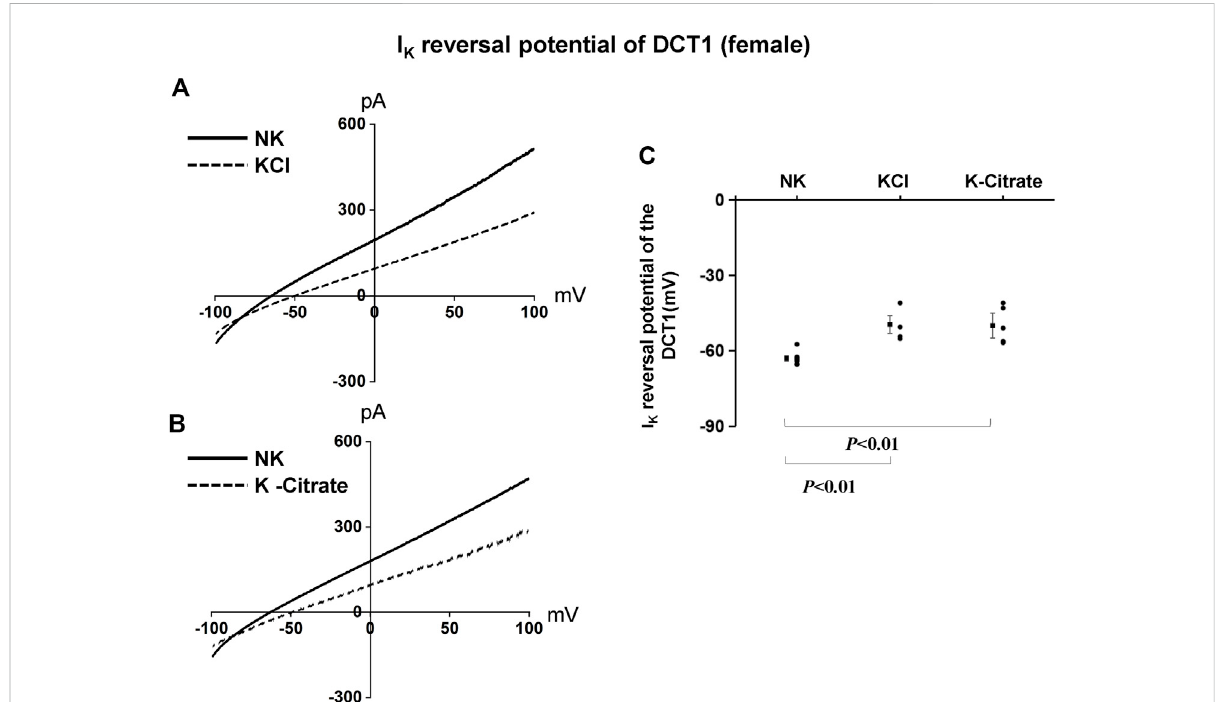
FIGURE 7 HK similarly depolarizes the basolateral membrane of the DCT in female mice regardless Cl − content. A set of whole-cell recordings shows I K reversalpotentialintheDCToffemalemiceonNKor5%K-Cldietfor7 days (A) andonNKor5%K-citratedietfor7 days (B) .Forthemeasurementof I K reversal potential, the bath solution contained 140 mM NaCl and 5 mM KCl, and the pipette solution contained 140 mM KCl. (C) A scatter graph summarizes theresults ofexperimentsinwhichI K reversalpotentials weremeasured intheDCT offemalemice ondifferentK + diets.The mean value and SEM are shown on the left of each